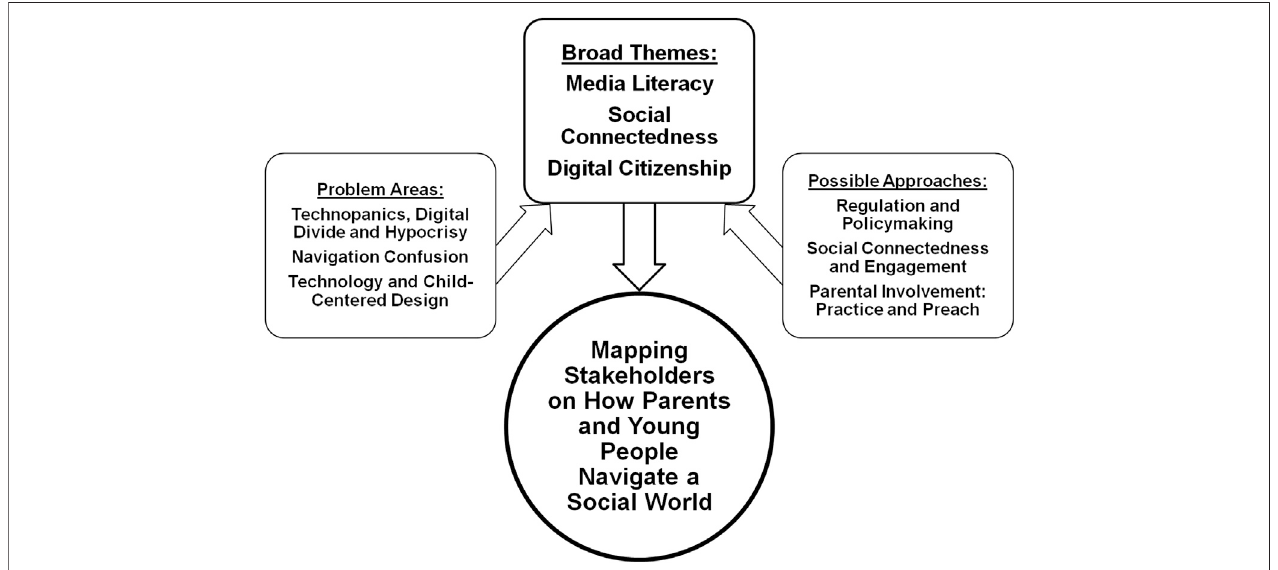
FIGURE 2 | Main themes from the interview